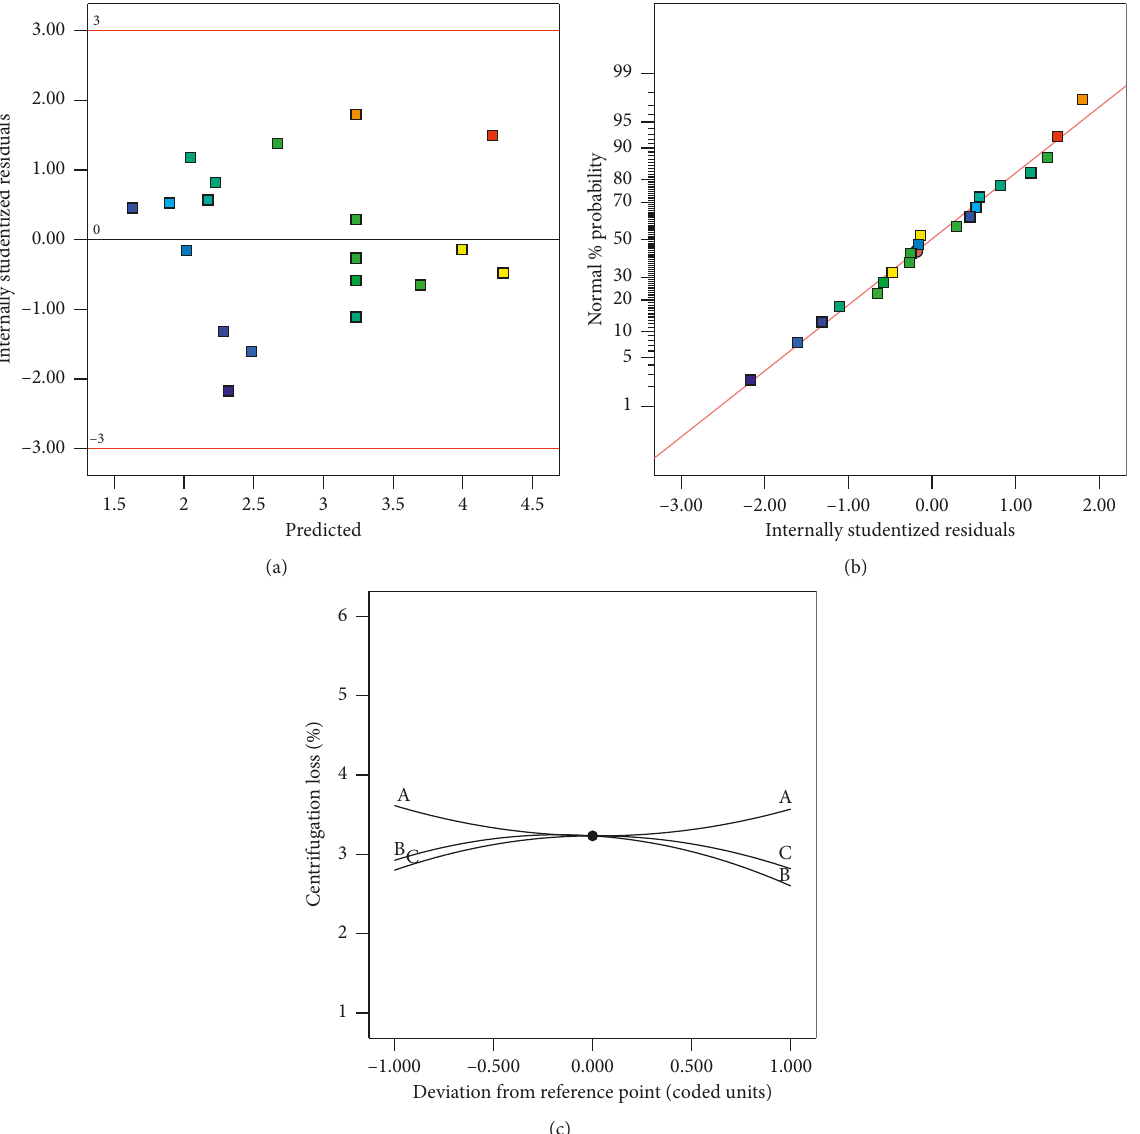
Figure 8: Response surface model diagnostic analysis of centrifugal loss. (a) Internally studentized residuals of the predicted value; (b) Internally studentized residuals of the normal ploy; (c) Perturbation curve. Actual factors: (A) electrode distance � 10cm, (B) needle distance � 8cm, and (C) voltage �